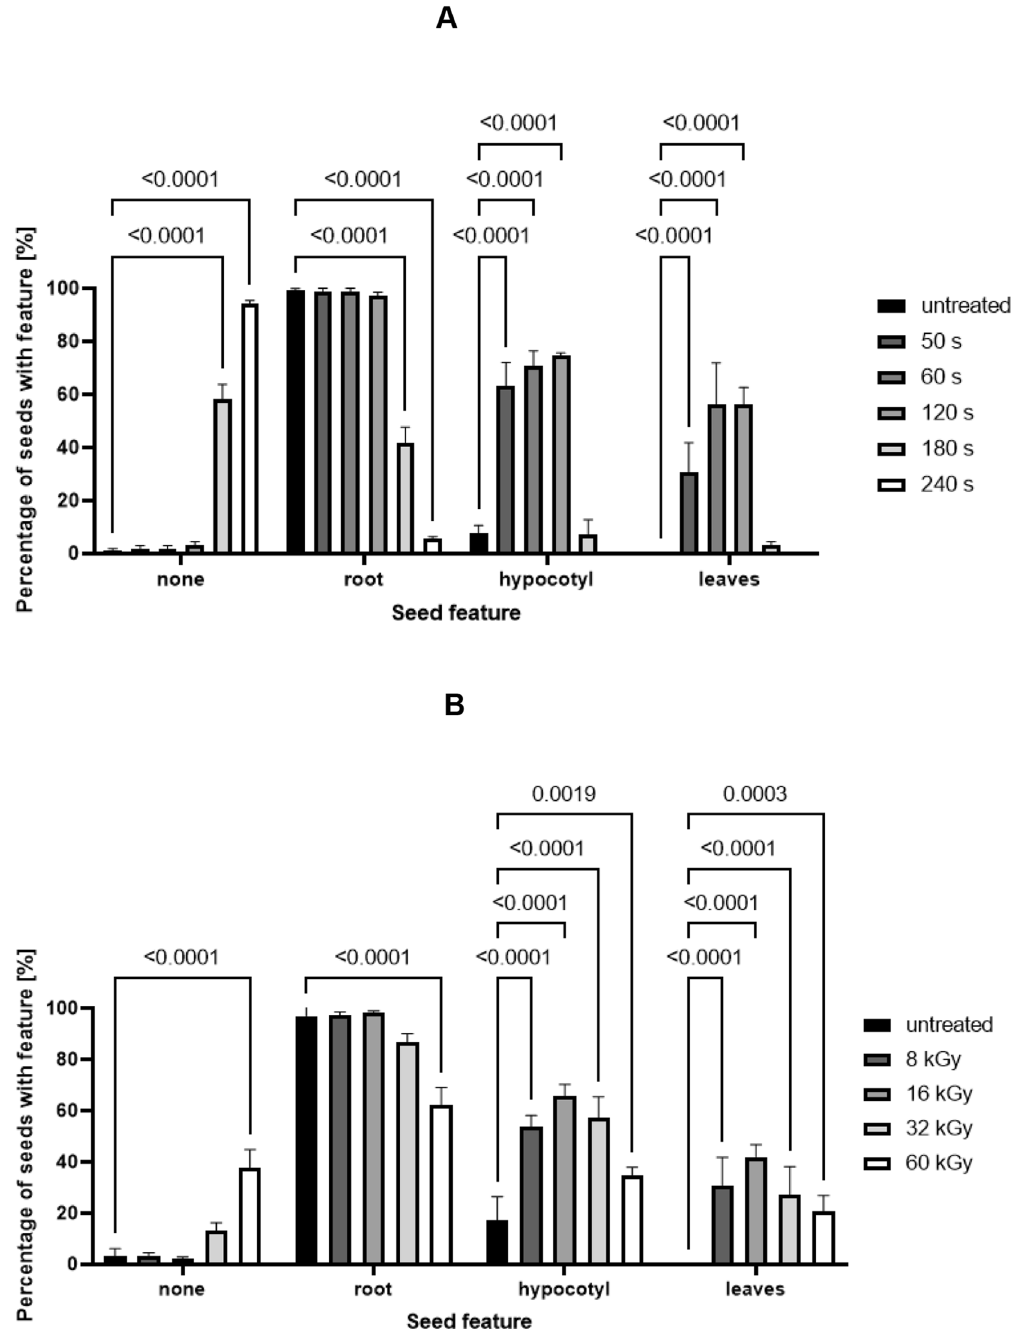
Figure 4. Quantitative assessment of seedlings grown from CAP and LEEB treated lentil seeds. ( A ) Quantitative assessment of 3-day-old seedlings from untreated and CAP treated seeds revealed accelerated seed germination compared to the untreated controls. Starting from 180 s, the germination capacity decreased and culminated in a complete lack of germination after 240 s treatment. ( B ) Quantitative assessment of 3-day-old seedlings grown from untreated and LEEB treated seeds revealed accelerated germination compared to the control, which is indicated by a higher percentage of seeds with hypocotyl and leaves. Starting from 32 kGy, the percentage of dormant or dead seeds increased. Columns are means of three independent experiments (N = 3), each comprising the analysis of 66 seeds. Significance of differences is indicated by the respective